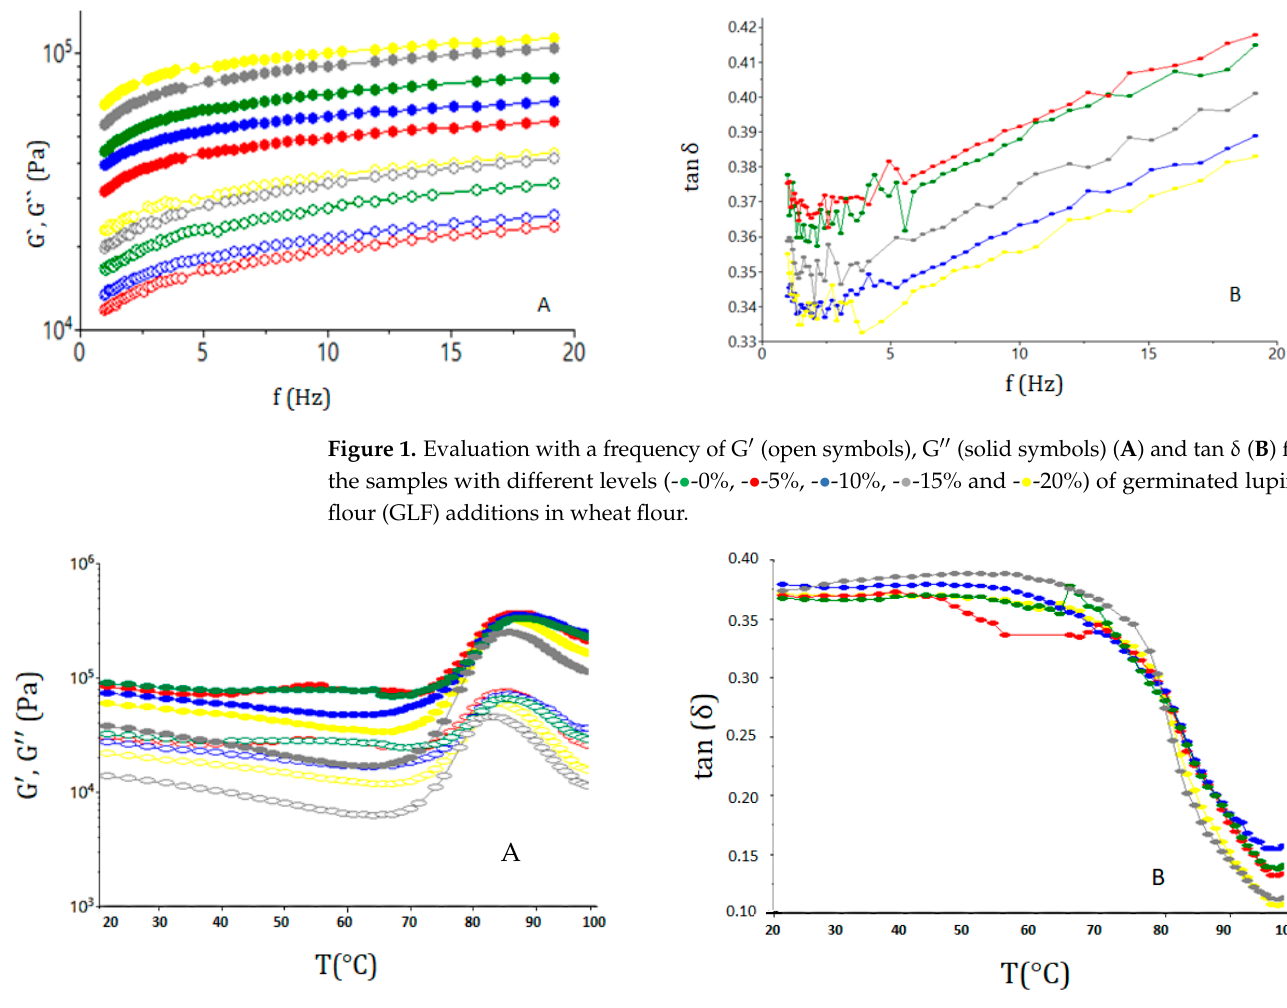
Figure 2. Evaluation of the temperature of the G ′ values (open symbols), G ′′ (solid symbols) ( A ) and tan δ ( B ) for the samples with different levels (-•-0%, -•-5%, -•-10%, -•-15% and -•-20%) of germinated lupine flour (GLF) additions in wheat flour.